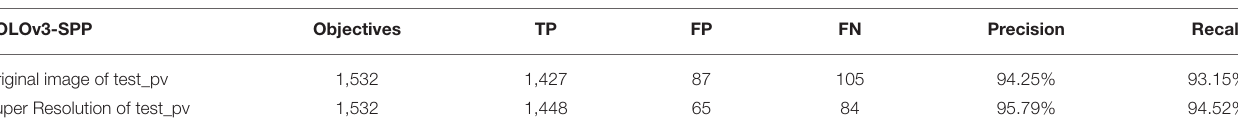
TABLE 3 | The detection results on test_pv